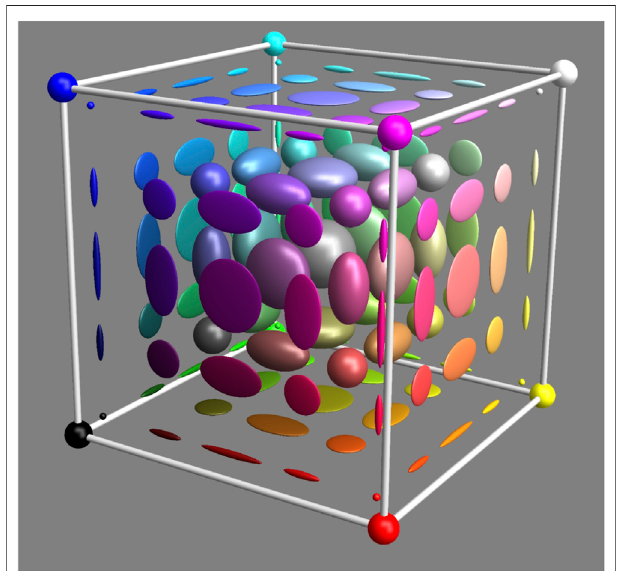
FIGURE 18 | Metameric confusion regions are space variant (Note that the optimal colors are not affected at all.) This is a simpli fi ed sketch of what happens. Near the faces of the RGB cube the confusion region fl attens, near the edges they become needle-shaped, near the vertices (optimal colors) they become arbitrarily small